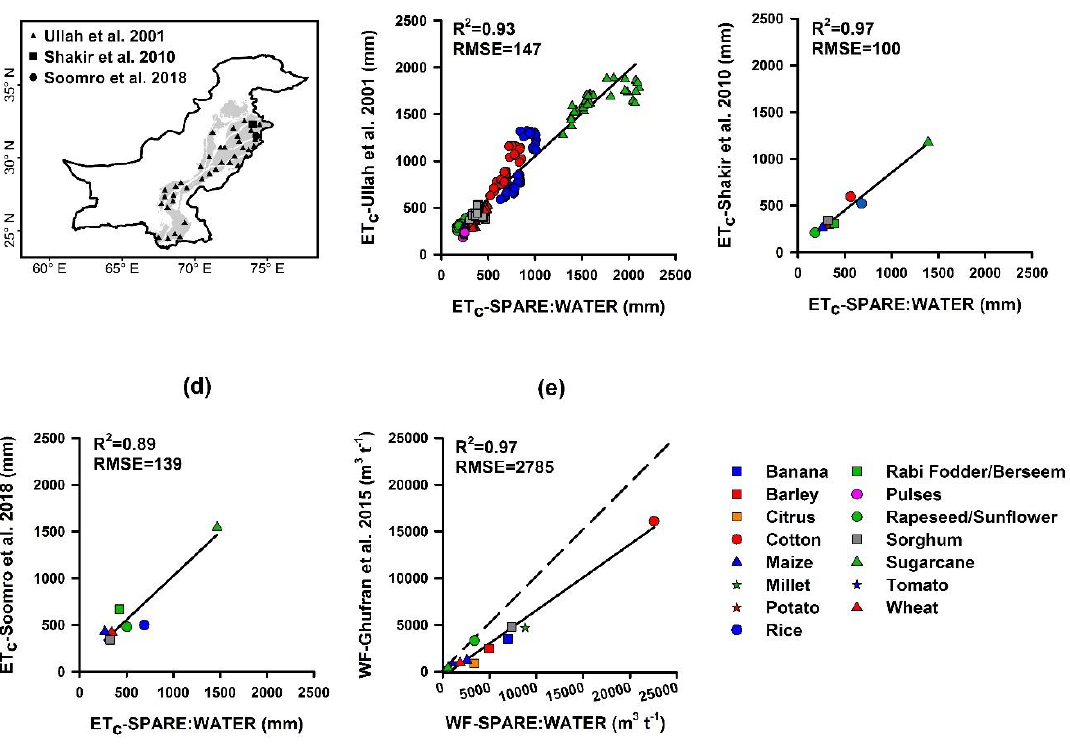
Figure 2. Comparison of SPARE:WATER with literature data: ( a ) location of data points used in model comparison; ( b , c , d ) correlations of simulated crop evapotranspiration (ET c ) with measured data; ( e ) correlation of simulated crop water footprints (WF crop ) with CROPWAT simulations.